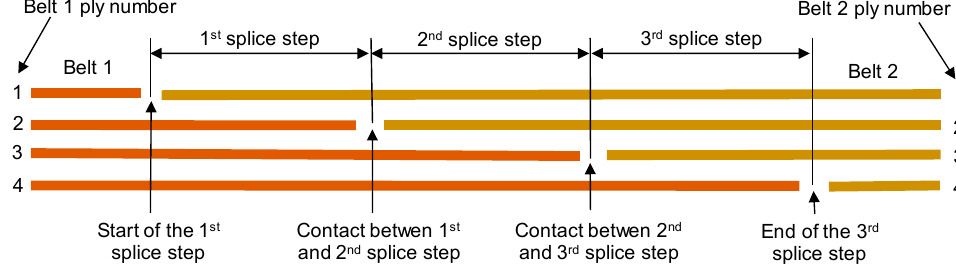
Figure 4. Schematic drawing of a splice in a 4-ply belt.